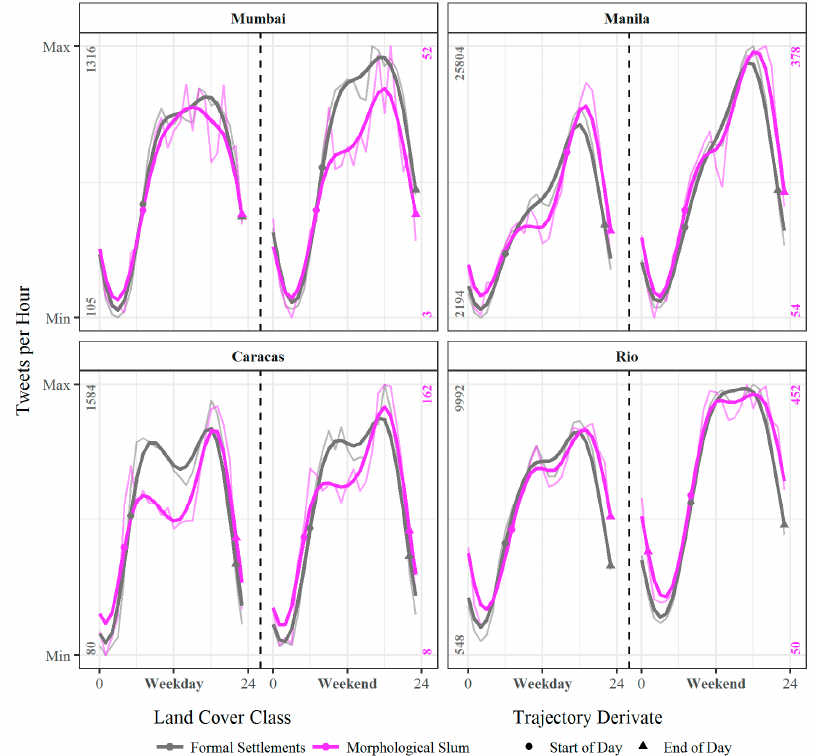
Figure 6. Temporal signatures for weekdays and weekends for each city and land cover class under investigation. Bold, smooth lines are spline fitted models over lighter colored raw data (ragged lines). Points and triangles mark trajectory derivates.